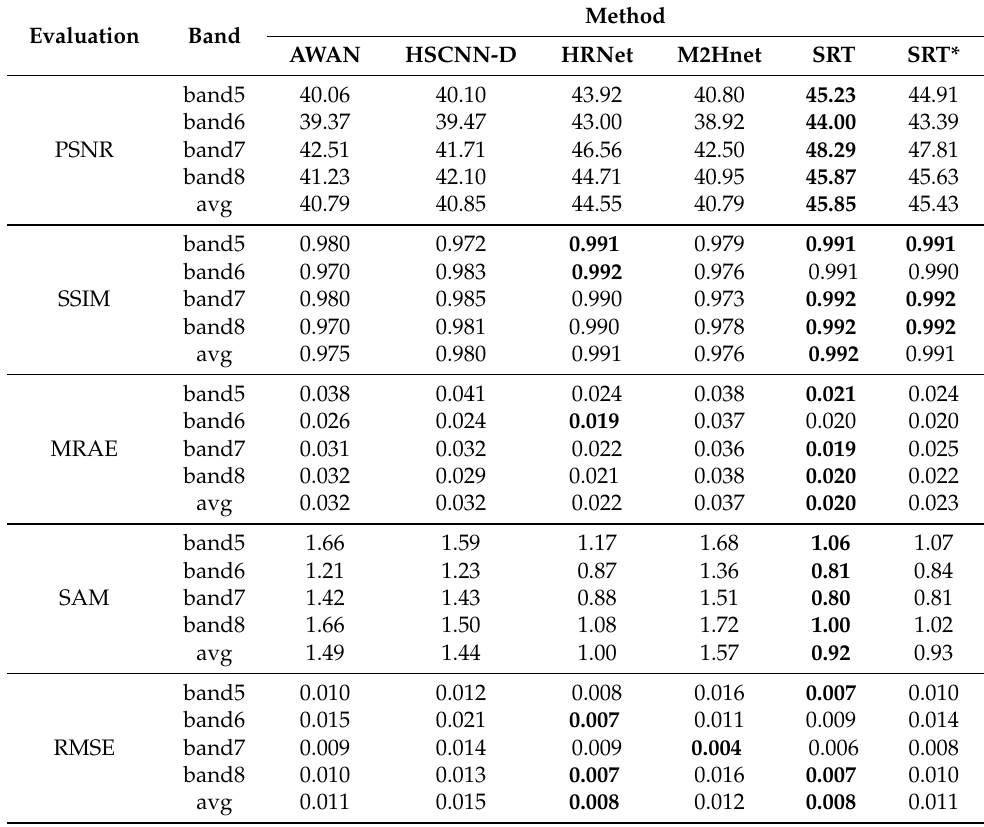
Table 4. Quantitative assessment of different spectral reconstruction methods for the dataset. The best results are shown in